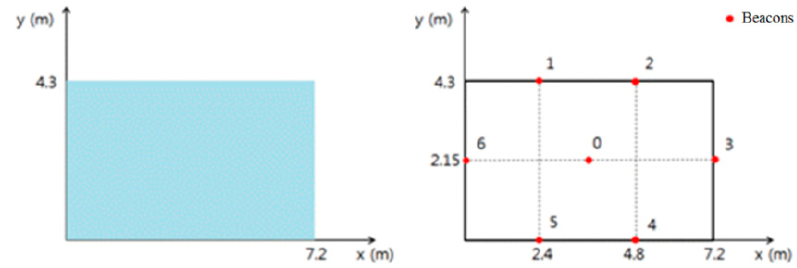
Figure 11. The coordinate system and location beacons deployment plot of the testing space.